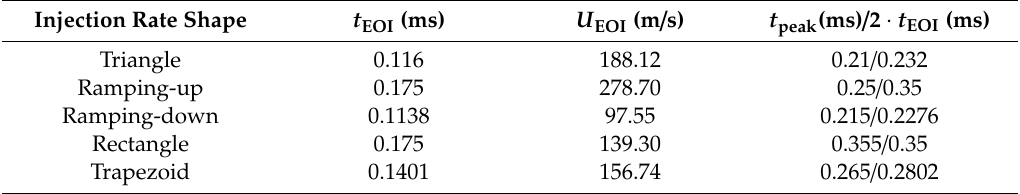
Table 2. Calculation results of t EOI and U EOI for injection quantity of 0.417 mg.